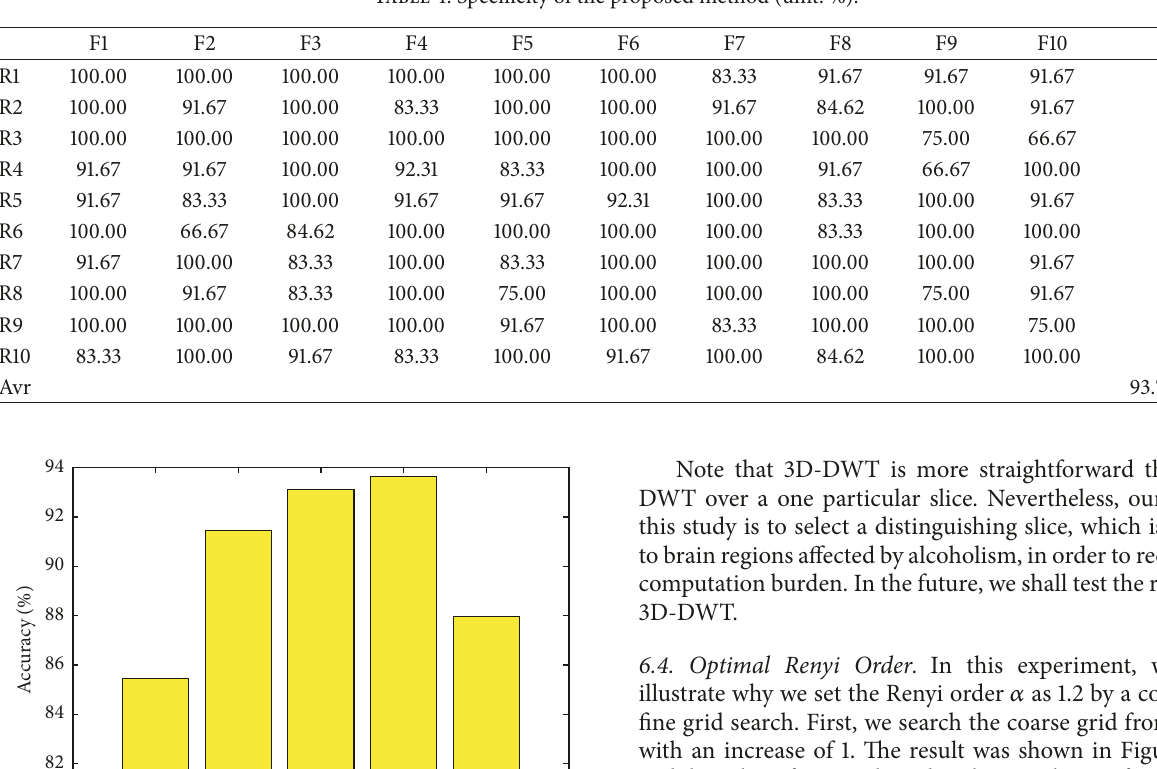
Table 4: Specificity of the proposed method (unit: %).